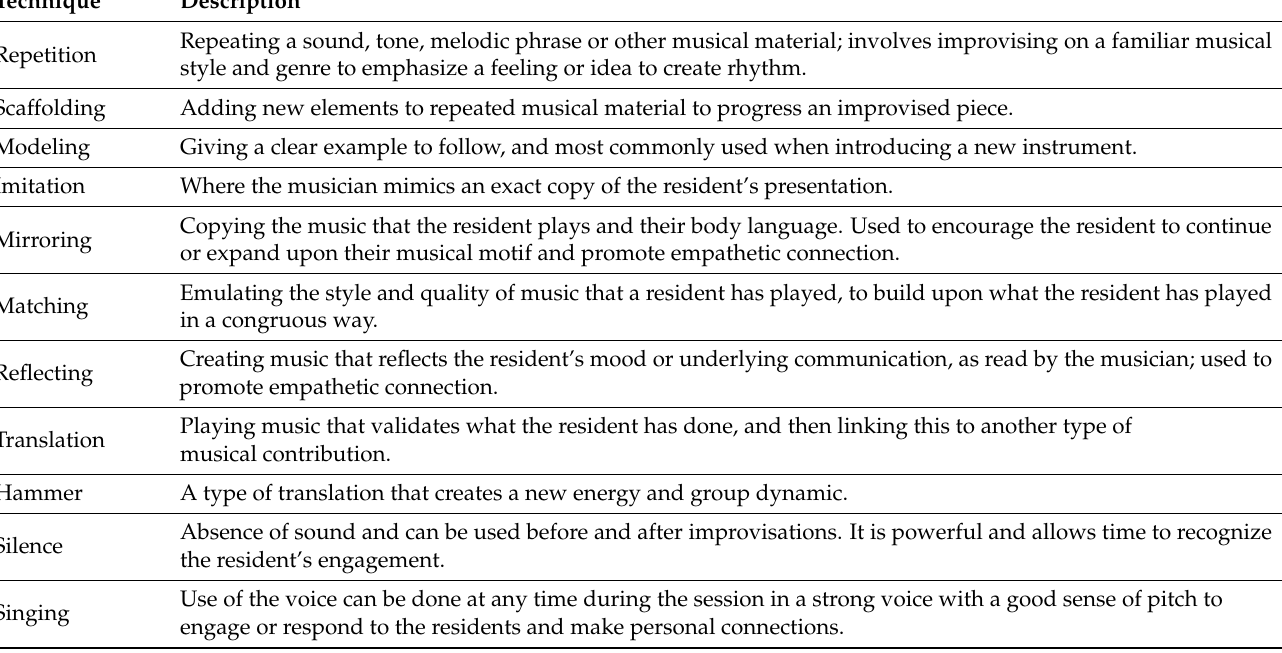
Table 1. Musical techniques for use in Music Connects Us